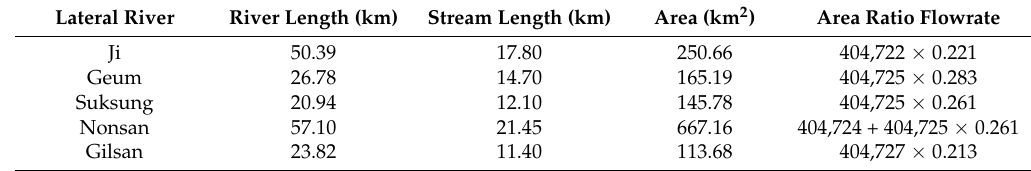
Table 8. Data on tributaries downstream of Daecheong Dam.